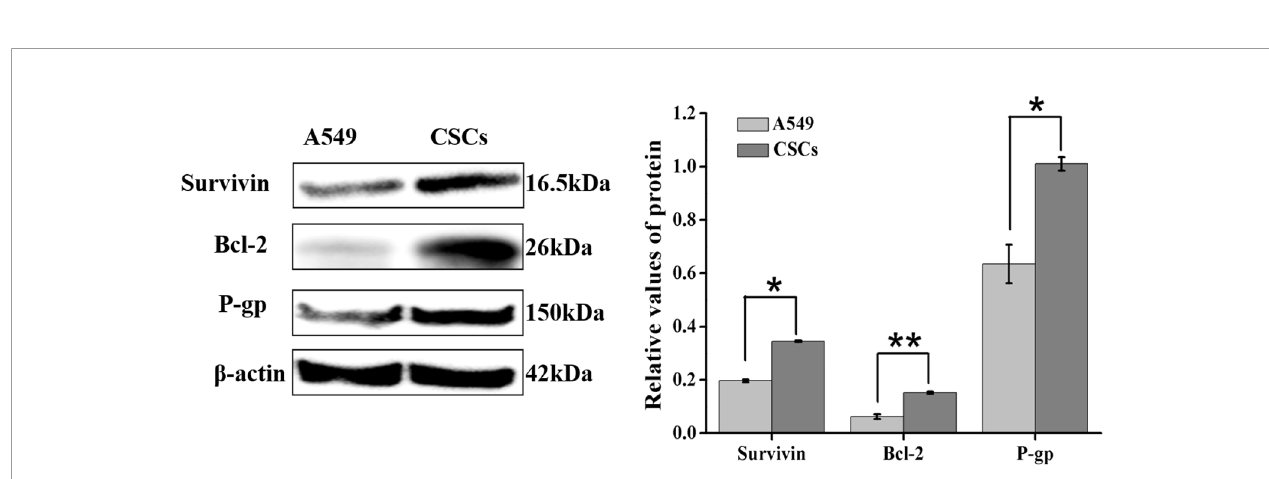
FIGURE 9 | Differential expression of survivin, Bcl-2, and P-gp in A549 parental cells and CSCs were detected by Western blot. Data were expressed as mean ± SD ( n = 3). * P < 0.05 and ** P <